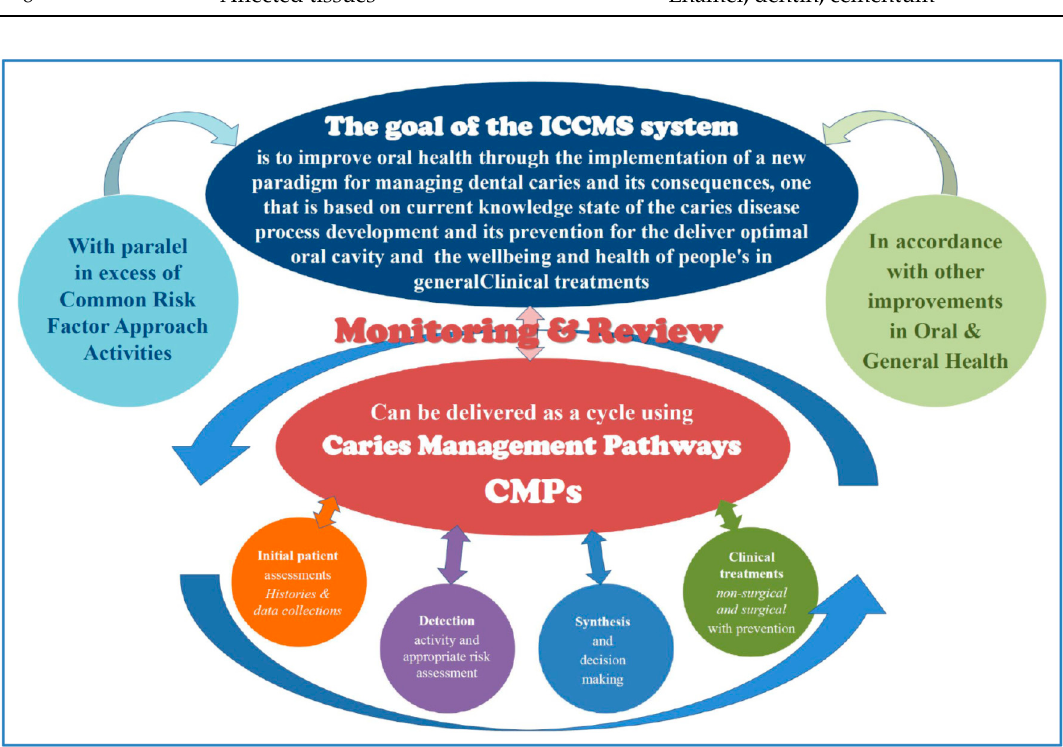
Figure 8. Scheme of the International Caries Classification and Management System (ICCMS).